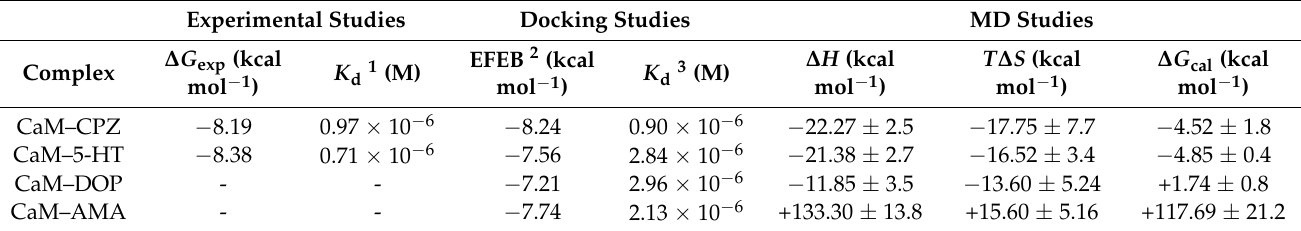
Figure 4. Fluorescence spectra and titration curves of h CaM M124C- mBBr with 5-HT ( A ) and CPZ ( B ). Buffer was 10 mM of potassium acetate pH 5.1 at 37 ◦ C. The absolute changes of maximal fluorescence emission were corrected for light scattering effects and plotted against the ligands-to-total-protein ratio (insets). The continuous line in the insets comes from the fitting of data to the binding model (Equation ((1)) to obtain the K d . Table 1. Experimental and theoretical binding properties of Ca 2+ -CaM–ligand complexes. Experimental Studies Docking Studies MD